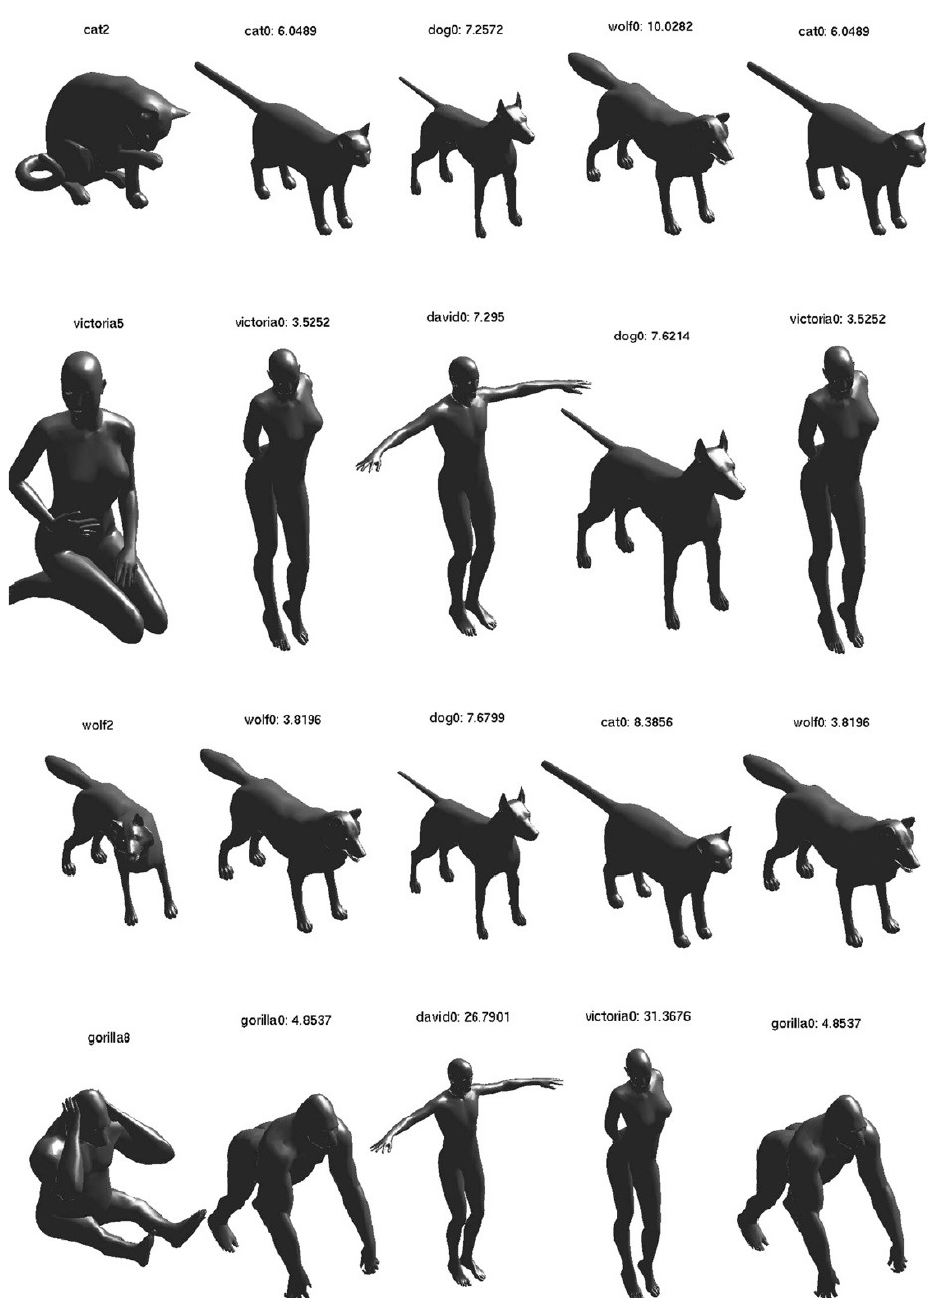
Figure 27. The Figure Shows Examplar Shape Recognition Results. The first column denotes the query shape, the second to the fourth columns show the three closest matches. The figure is originally from